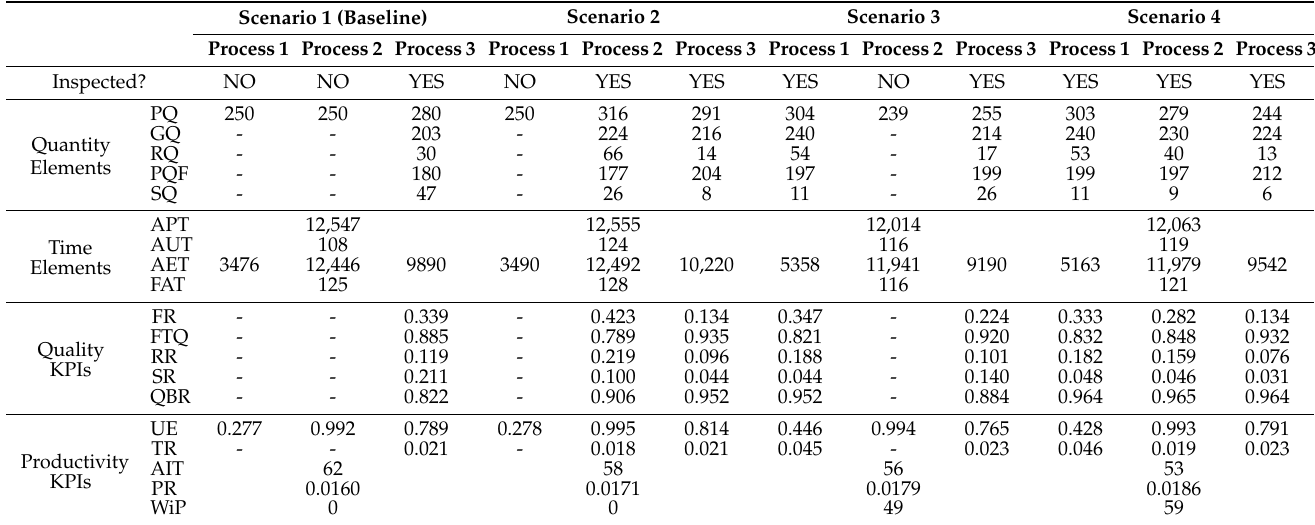
Table 4. Simulation results for different inspection strategies with limited material